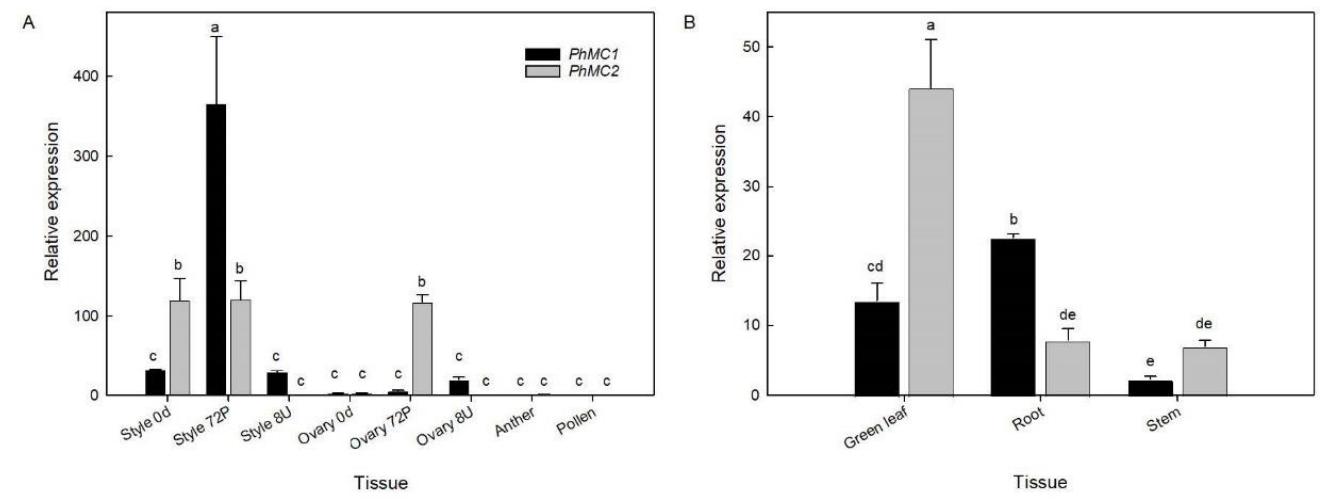
Figure 4. Metacaspase gene expression in floral and vegetative tissues from Petunia × hybrida ‘Mitchell Diploid’ (MD) ( A ) Relative expression of PhMC1 and PhMC2 in styles and ovaries from unpollinated flowers on the day of anthesis (0 days), from pollinated flowers at 72 h (72 P), and from unpollinated, naturally senescing flowers at 8 days (8 U). Anthers were collected on the day of flower opening and pollen was from freshly dehiscent anthers. ( B ) Relative expression of PhMC1 and PhMC2 in green leaf, root, and stem tissue. Relative mRNA abundance compared to PhACTIN was determined by quantitative PCR and values represent the mean ± SD, n = 3. Different letters represent statistically significant difference between the means ( p ≤ 0.05).